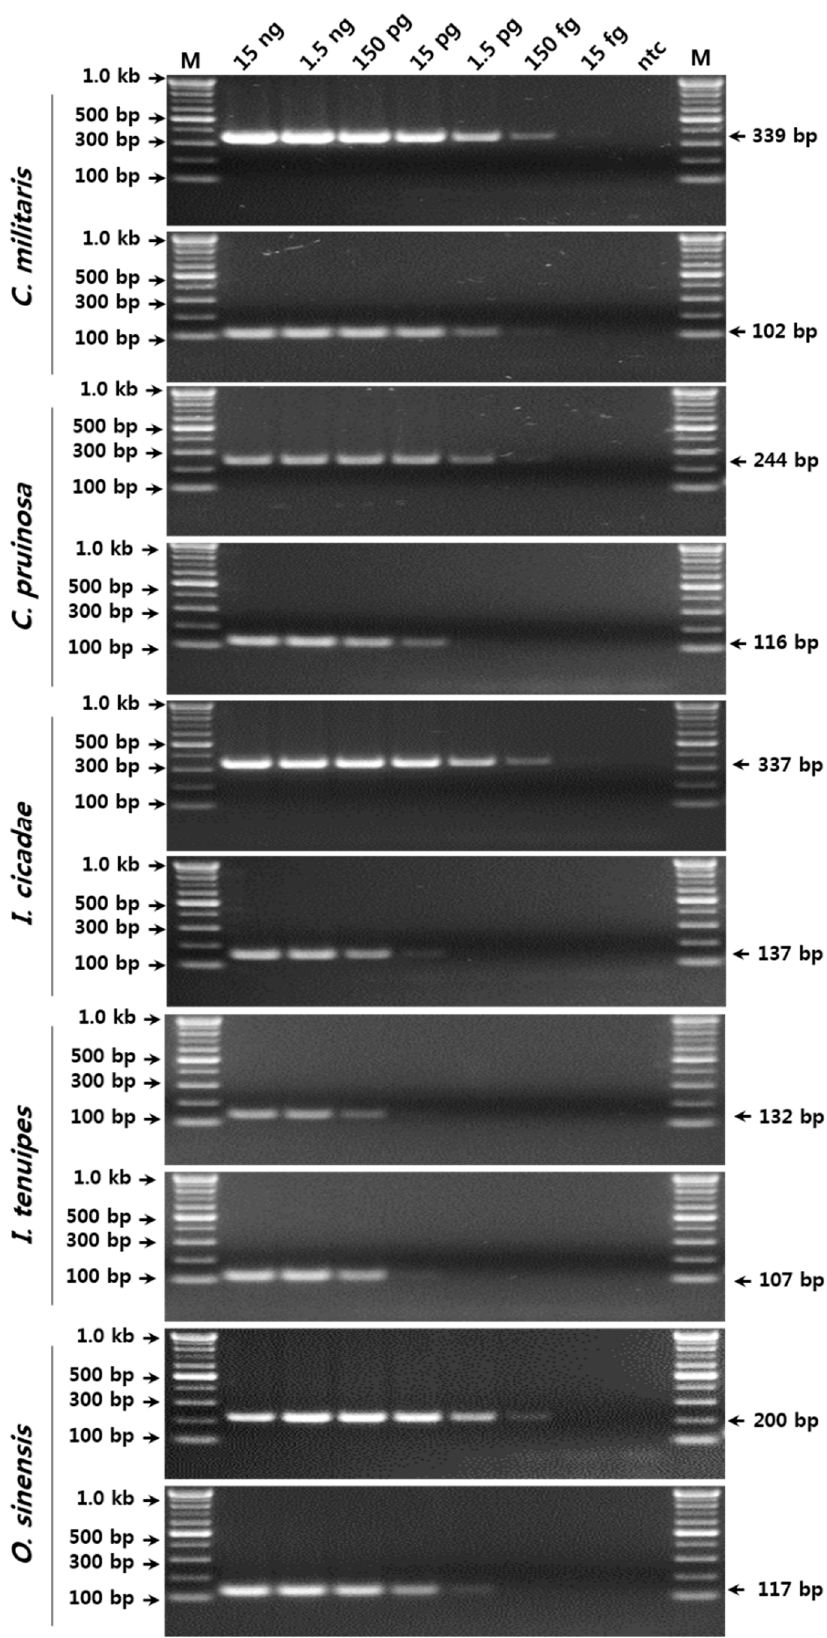
Figure 2. Verification of the detection limit of the SCAR markers using serial dilutions of template DNA. The precise lengths of the PCR products and the DNA ladders are indicated to the right and left of the gel images, respectively. M, 100 bp DNA ladder.